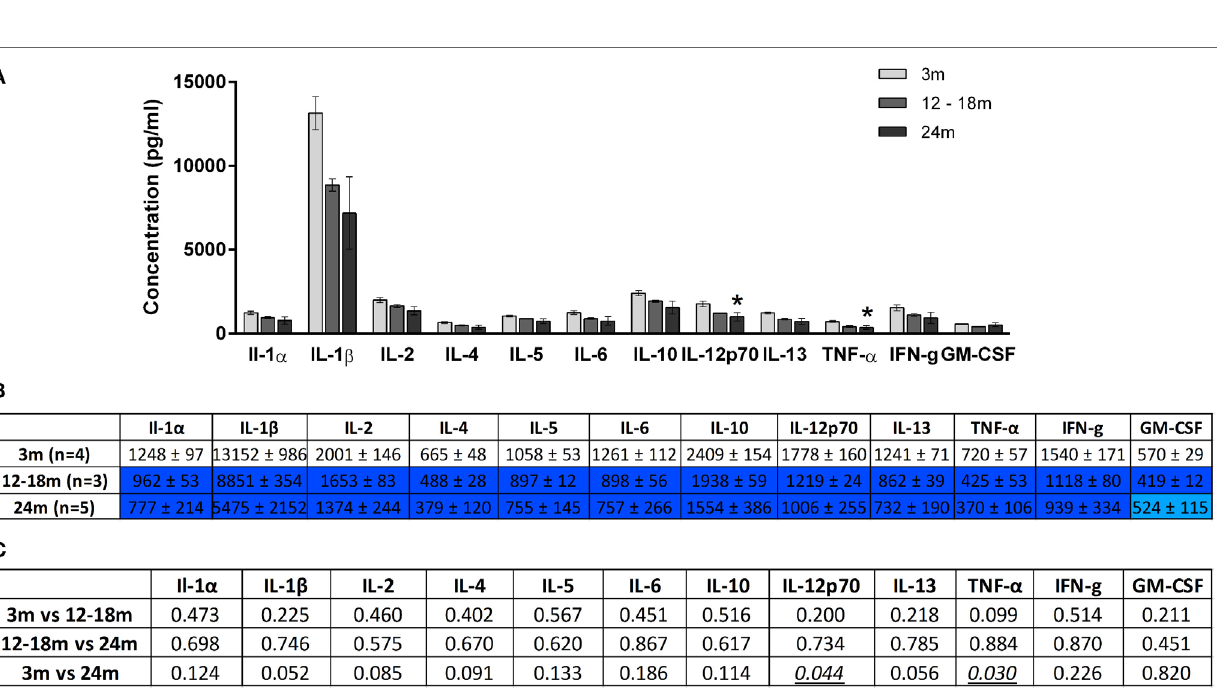
FigUre 4 | (a) Cytokine levels (picogram/milliliter, mean ± SEM) in the brainstem of 3-, 12- to 18-, and 24-month-old rats. A single asterisk and double asterisks denote p < 0.05 and p < 0.01 vs. 3 months, respectively. A single star and double stars denote p < 0.05 and p < 0.01 vs. 12–18 months, respectively. (B) Color-coded table showing changes in cytokine levels in the brainstem (mean ± SEM). Compared to 3-month-old rats (no color), > 15% increase is represented by light red and > 25% by dark red, > 15% decrease is represented by light blue and > 25% by dark blue. (c) Summary of p -values of brainstem cytokine changes with age. Statistically significant differences are italicized and underlined. Note that changes in IL-5 and GM-CSF showed trends that were not statistically